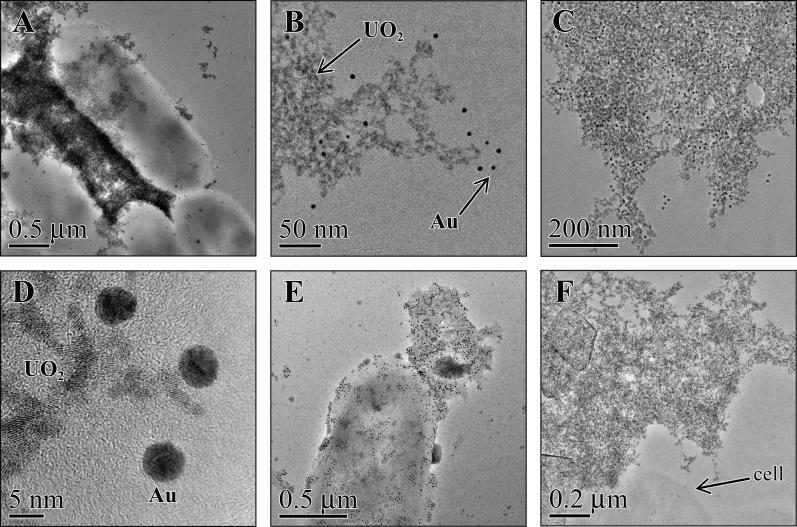
Immune-Localization of MtrC, OmcA, and MtrB with Extracellular UO
2 from
S. oneidensis MR-1
Whole-mount TEM images of MR-1 incubated with 100 μM U(VI) for 24 h and reacted with specific antibodies to MtrC (A, B), OmcA (C, D), or MtrB (E). High-resolution image of nanocrystalline UO
2 associated with the extracellular matrix and the 5-nm particles of colloidal gold (Au) (B, D). Extracellular matrix and cell labeled with colloidal gold in the absence of specific antibody (F).